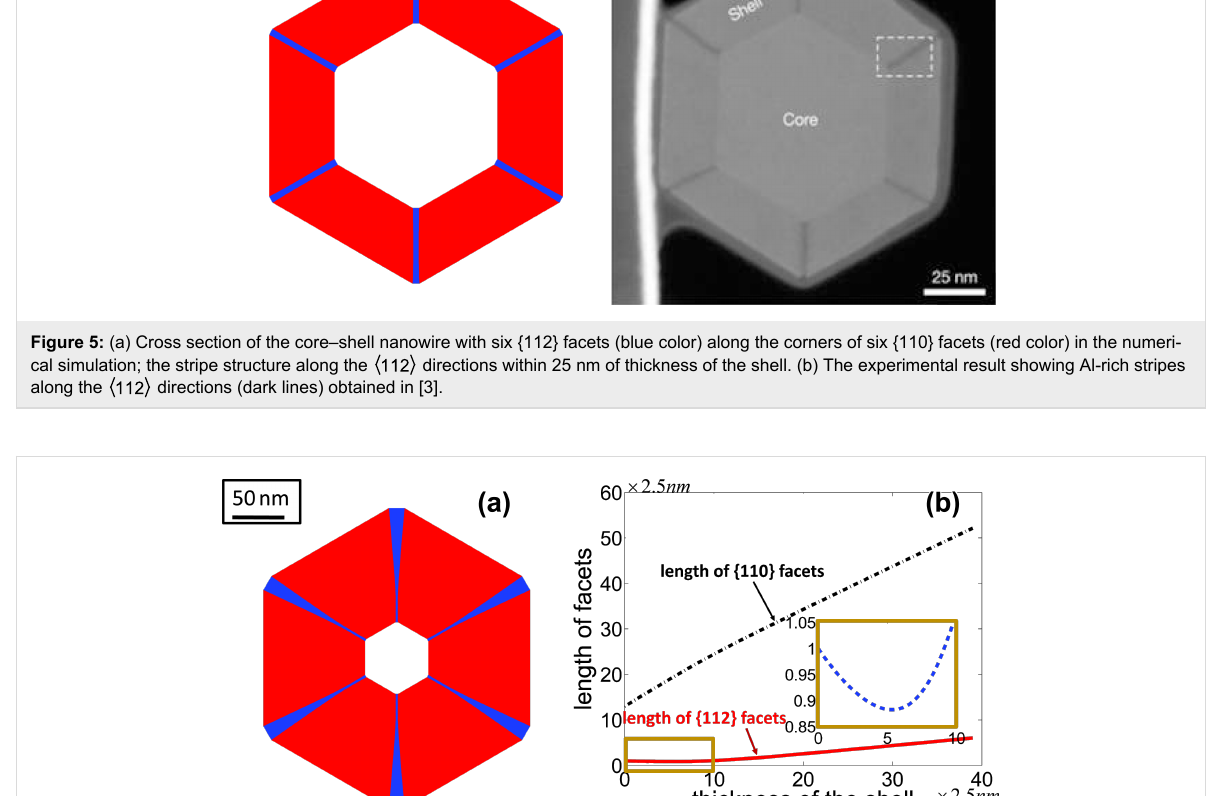
This conclusion departs from the traditional understanding on the formation of the Al-rich stripes along the